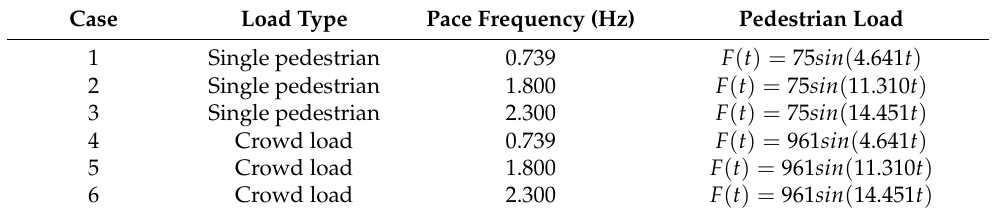
Table 2. Investigated pedestrian load